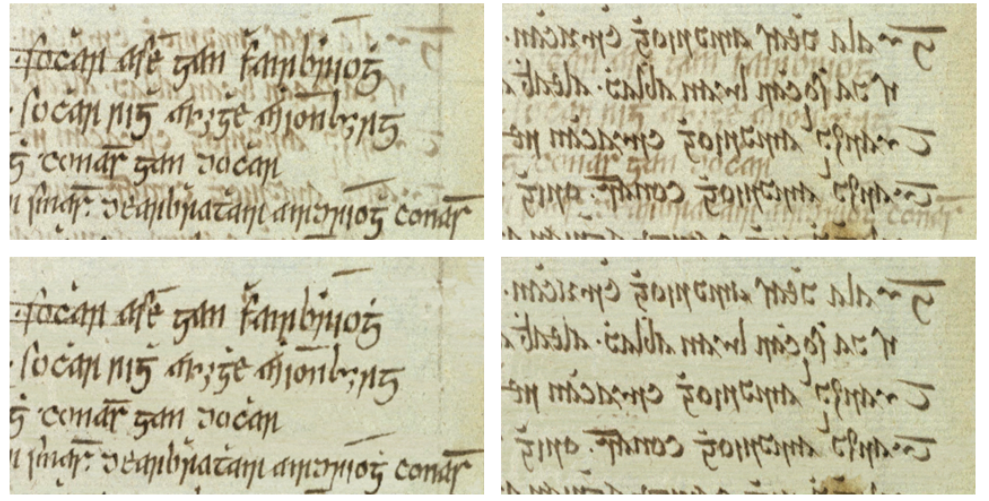
Figure 4. Ink bleed-through removal in a colour image: input image ( top ) and the restored image using the proposed method ( bottom